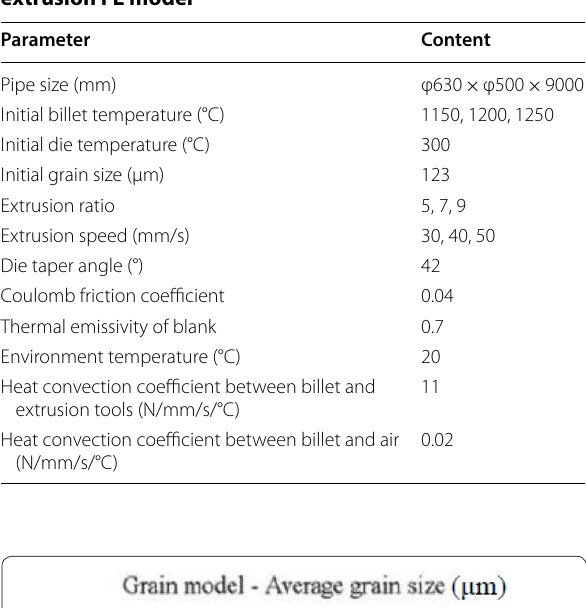
Table 5 Hot extrusion parameters for the coupled hot